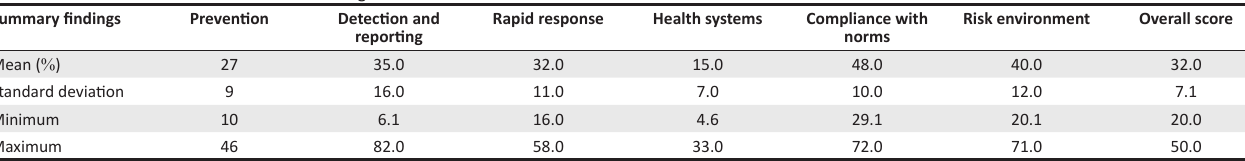
TABLE 4: Performance of the 42 WHO African Region member states in the GHS Index evaluation conducted in 2019. Summary findings